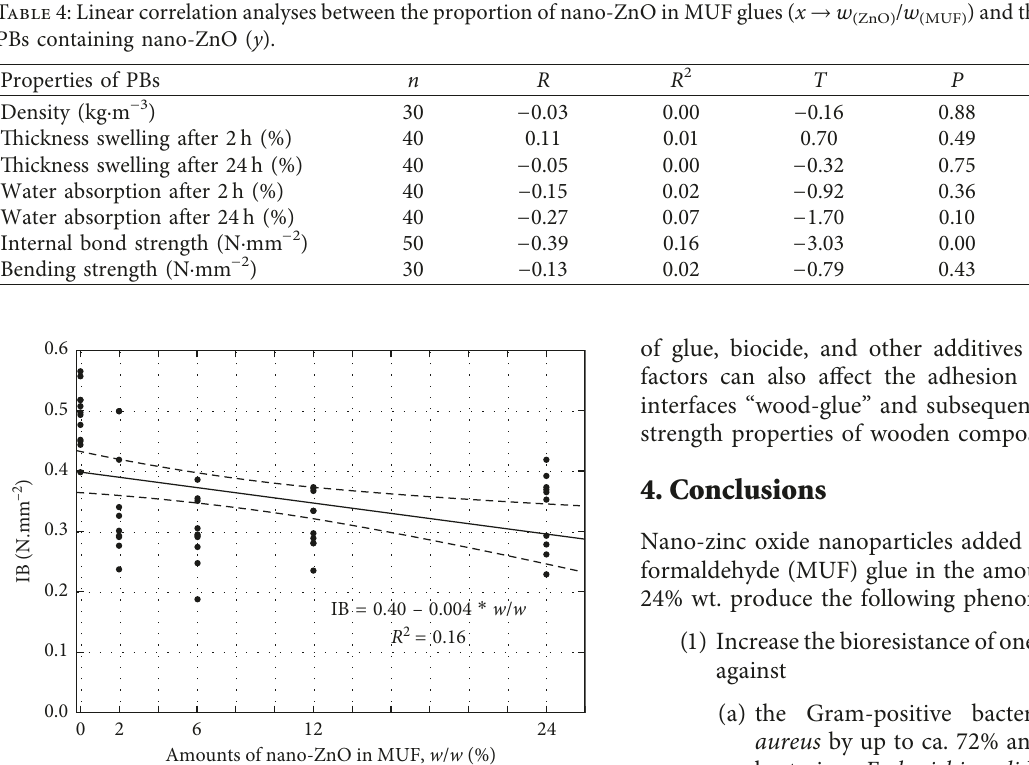
Figure 3: Linear correlation between a higher content of nano- ZnO in MUF glue ( w / w , %) used in the production of PBs and a reduced internal bond (IB) strength of the nano-ZnO-treated